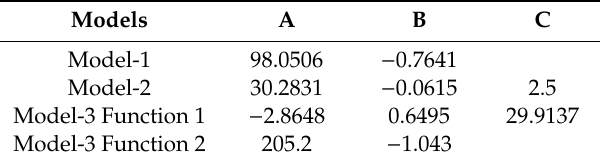
Figure 8. Scatter plot of normalized bistatic radar cross-section (NBRCS) and ECMWF reanalysis data. The color bars represent the density of the data. Left pannel is for Model-1 and Model-2, while Right pannel is for Model-3. Table 1. Fitting parameters of Model-1, Model-2, and Model-3.